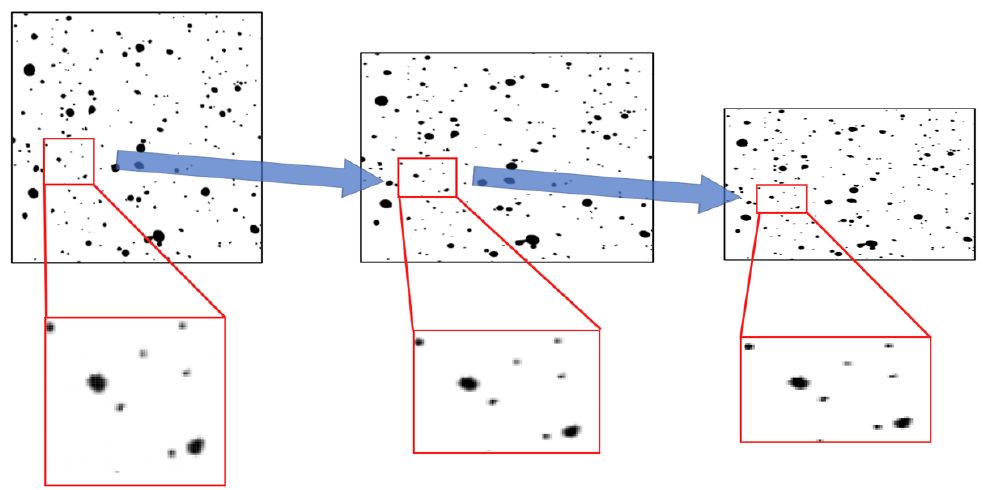
Figure A1. Schematic illustration of DIC subset tracking before and after deformation. As shown in Figure A2, in the reference image, the center point P ( x 0 , y 0 ) of the sub-area and any adjacent point Q ( x i , y i ) in the sub-area are P ’( x’, y’ ), Q ’( x’, y’ ) in the target subregion of the deformed image. A series of neighbors in the reference subregion are still neighbors of the center point in the target subregion, due to the continuity assumption of deformation.